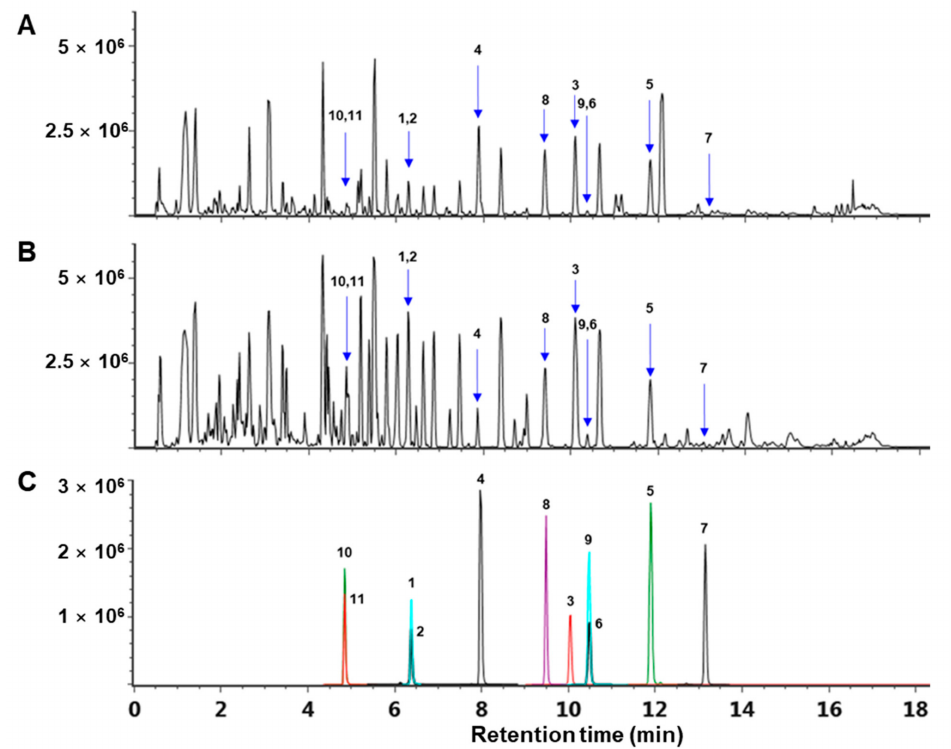
Figure 2. Representative negative ion mode mass chromatogram of ( A ) ASFEx, ( B ) AFB, and ( C ) isolated compounds ( 1–11 ) based on a